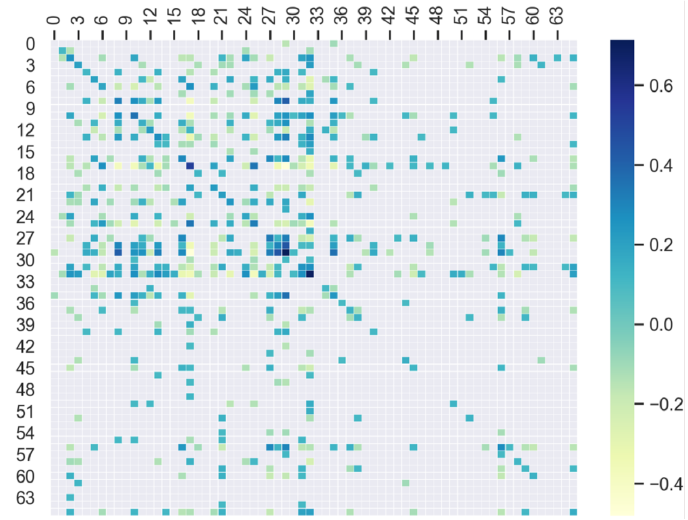
Figure 10. Weight matrix of 2-order feature combination.